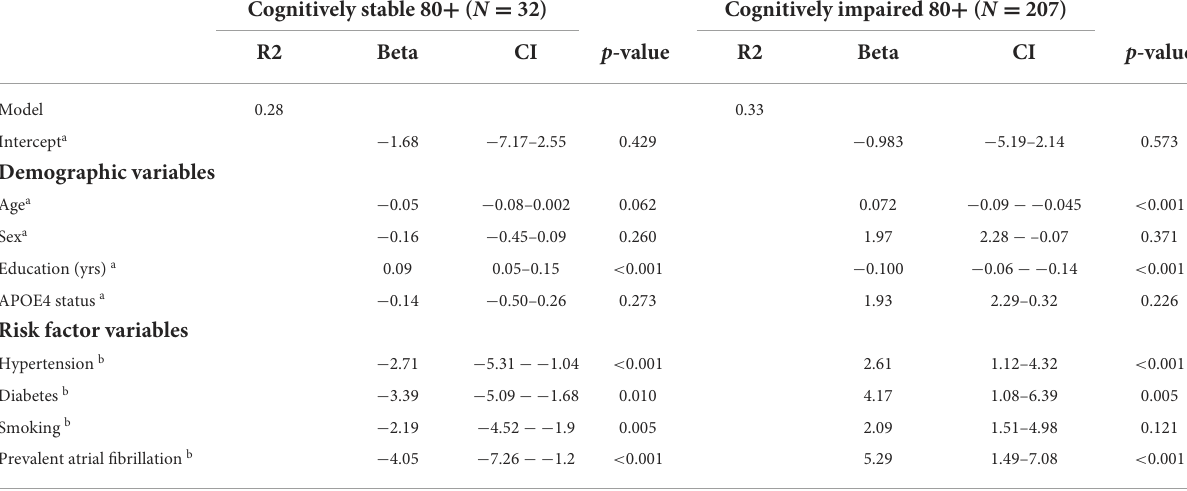
TABLE 7 Assessment of the predictive value of different risk factors in the DNS-br signature. Cognitively stable 80 + ( N =